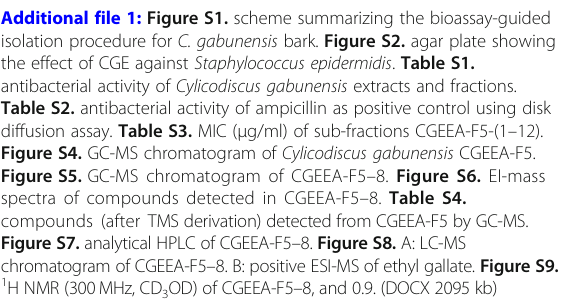
Table S2. antibacterial activity of ampicillin as positive control using disk diffusion assay. Table S3. MIC ( μ g/ml) of sub-fractions CGEEA-F5-(1 – 12). Figure S4. GC-MS chromatogram of Cylicodiscus gabunensis CGEEA-F5. Figure S5. GC-MS chromatogram of CGEEA-F5 – 8. Figure S6. EI-mass spectra of compounds detected in CGEEA-F5 – 8. Table S4. compounds (after TMS derivation) detected from CGEEA-F5 by GC-MS. Figure S7. analytical HPLC of CGEEA-F5 – 8. Figure S8. A: LC-MS chromatogram of CGEEA-F5 – 8. B: positive ESI-MS of ethyl gallate. Figure S9.